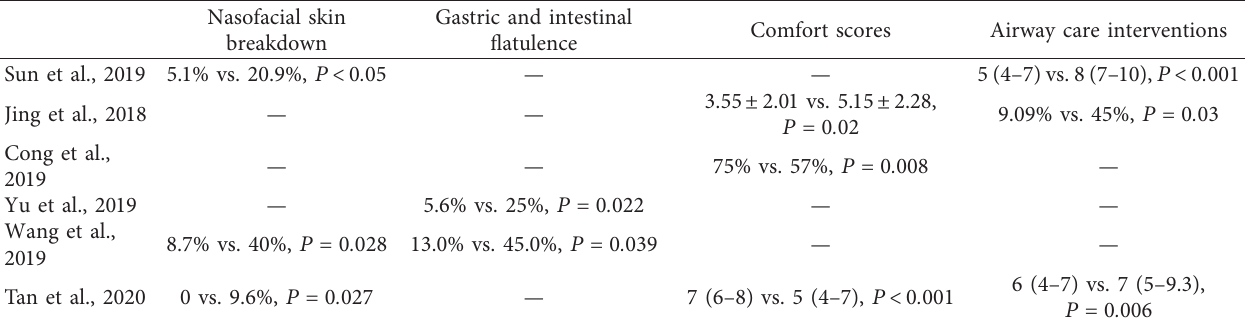
Figure 5: ICU stay. Table 4: Summary of patients’ comfort and